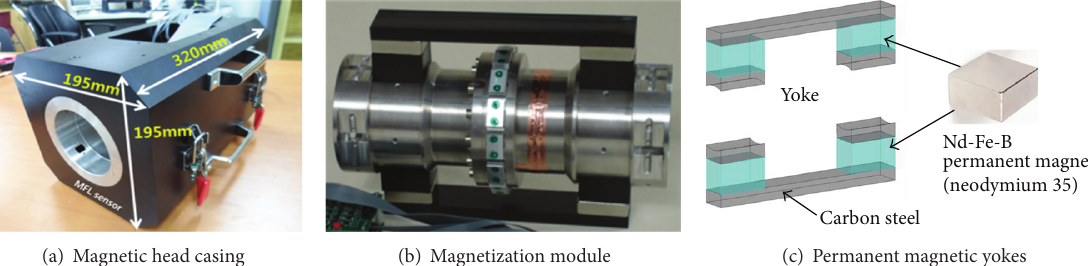
Figure 20: Magnetization module of the magnetic sensor.